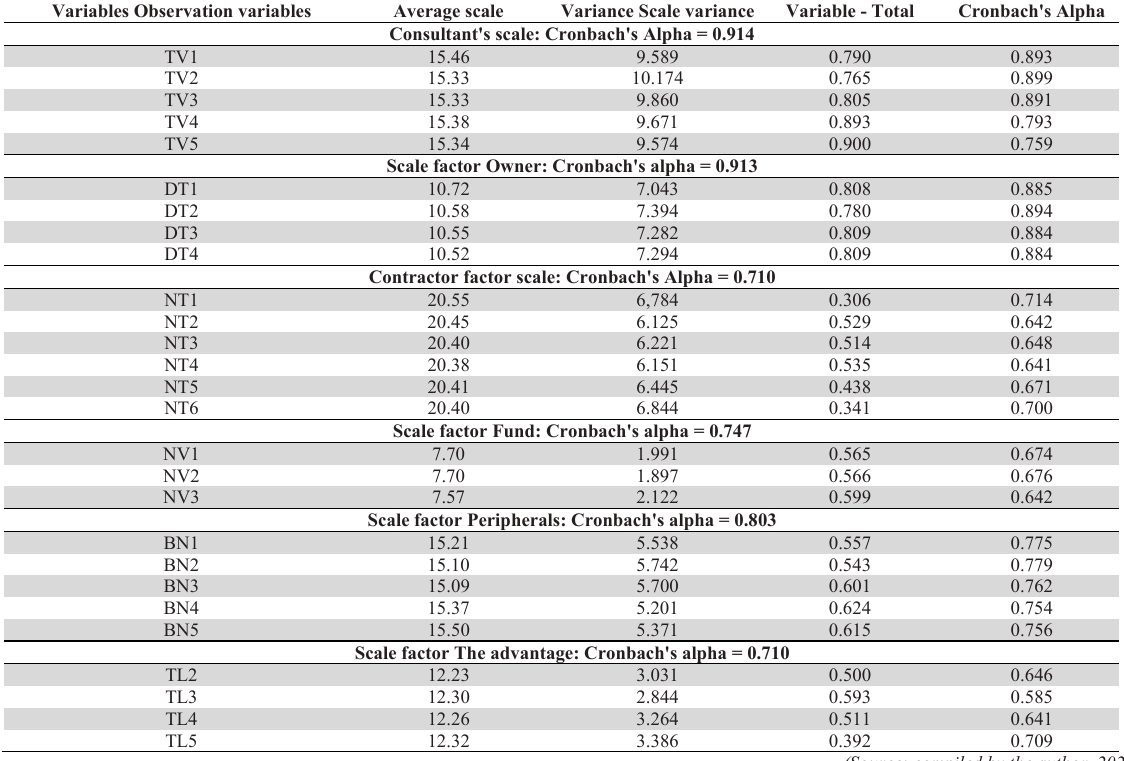
Cronbach's Alpha test results of scales Variables Observation